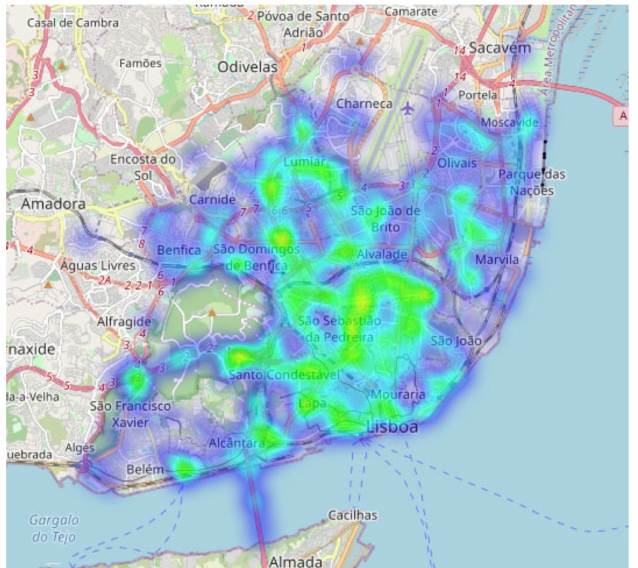
Figure 9. Collision distribution in Lisbon in 2019. Orange and yellow represent streets where more collisions occurred; green and blue represent less common places for collision